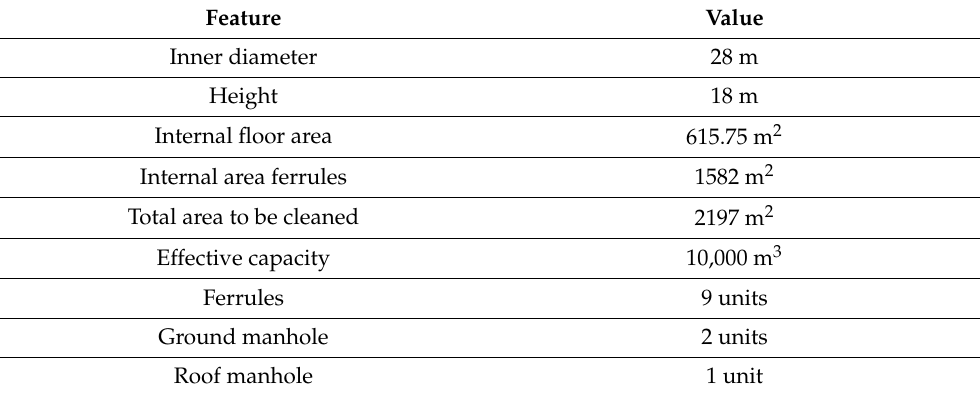
Table 1. Tank characteristics.